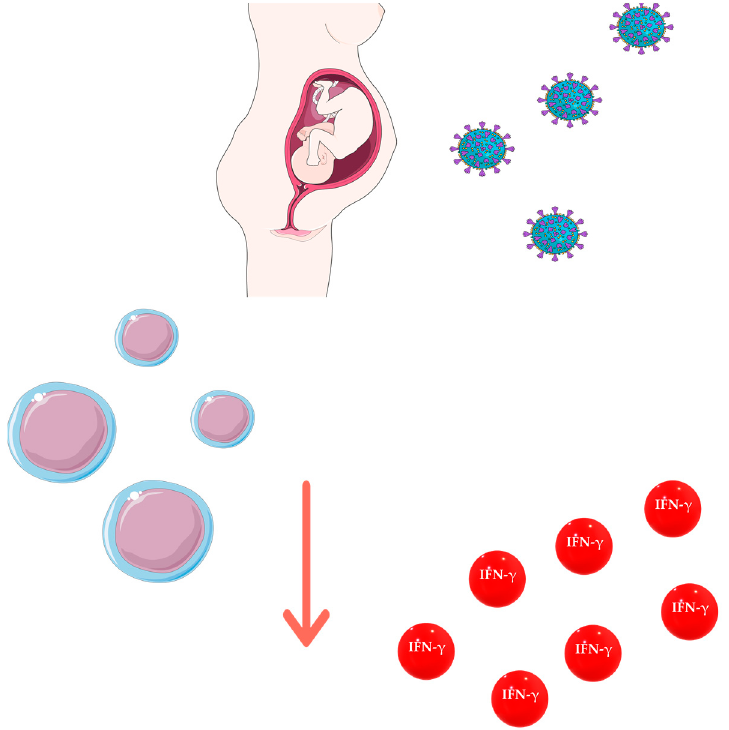
Figure 4. Schematic representation of lymphocyte and IFN- γ decrease in maternal and cord blood. Parts of the figure were drawn using pictures from Servier Medical Art by Servier, licensed under a Creative Commons Attribution 3.0 Unported License.